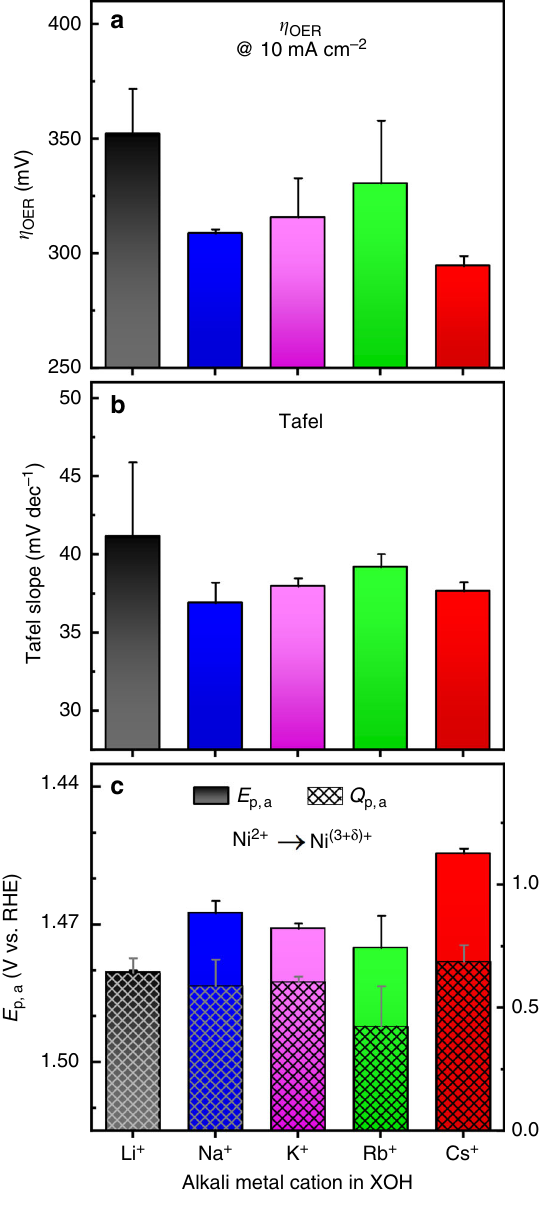
Fig. 2 OER activity trends at the in fl uence of alkali metal cations. The OER activity of the Ni 65 Fe 35 catalyst in puri fi ed 0.1M XOH electrolytes (X = Li + , Na + , K + , Rb + , and Cs + ) measured “ in house ” . a OER overpotential ( η OER ) at 10mAcm − 2 from steady-state conditions. b Tafel slope analysis extracted from steady-state conditions. c The anodic peak positions ( E p,a ) of the Ni 2 + → Ni (3 + δ ) + redox peak (left), and the corresponding integrated anodic peak charge ( Q p,a , right) obtained from CVs at 10mVs − 1 . All data in this fi gure was recorded using a reversible hydrogen electrode (RHE) as a reference electrode. Error bars show the standard error from the overall number of